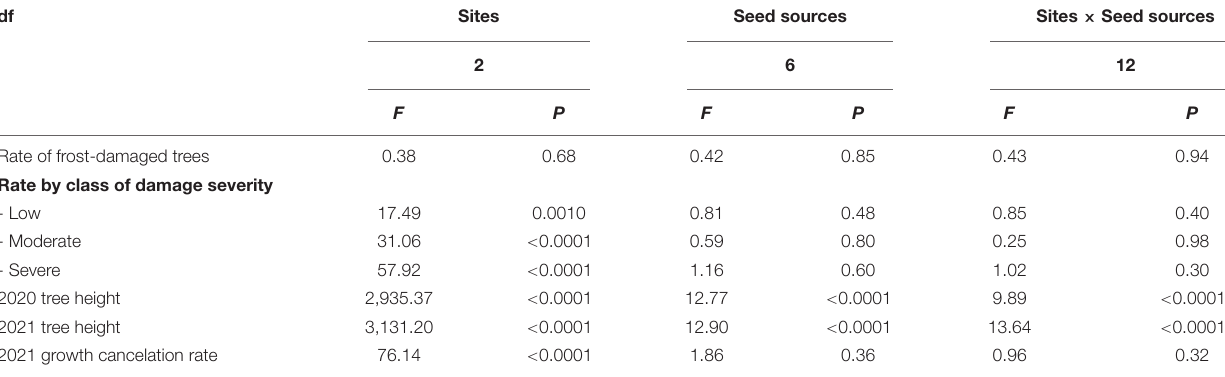
TABLE 1 | Results of analysis of variance for the rate of frost-damaged trees, the rate by class of damage severity, tree height, and growth cancelation rate for the various ANOVA effects (sites, seed sources, and the site × seed source interaction), degrees of freedom (df), F values, and associated probabilities ( P ). df Sites Seed sources Sites × Seed